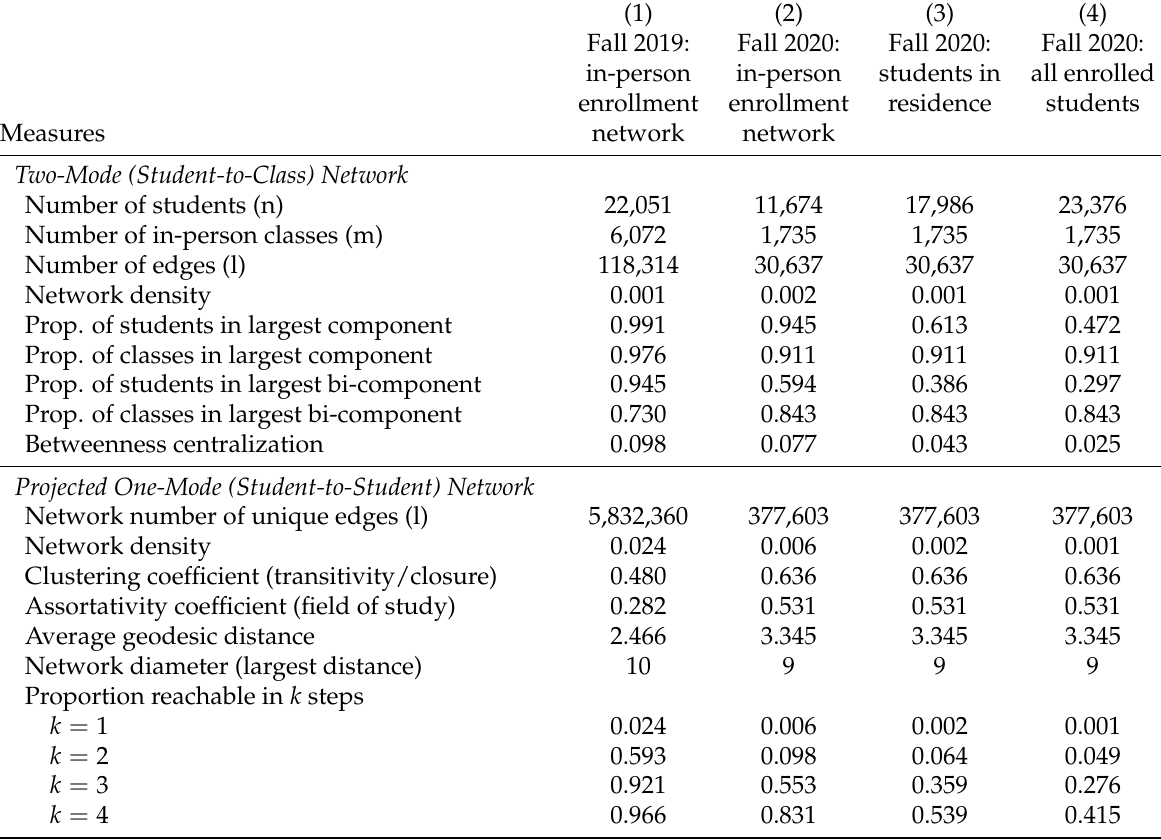
Table 1: The structure of co-enrollment networks, 2019 and